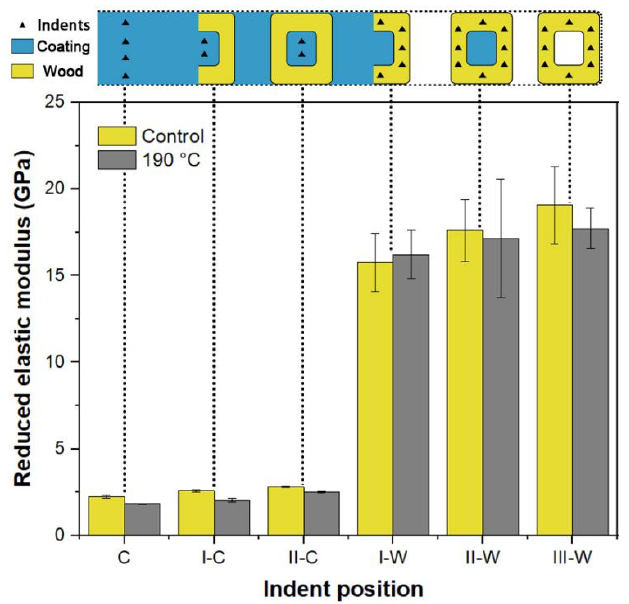
ff erent locations at the sample